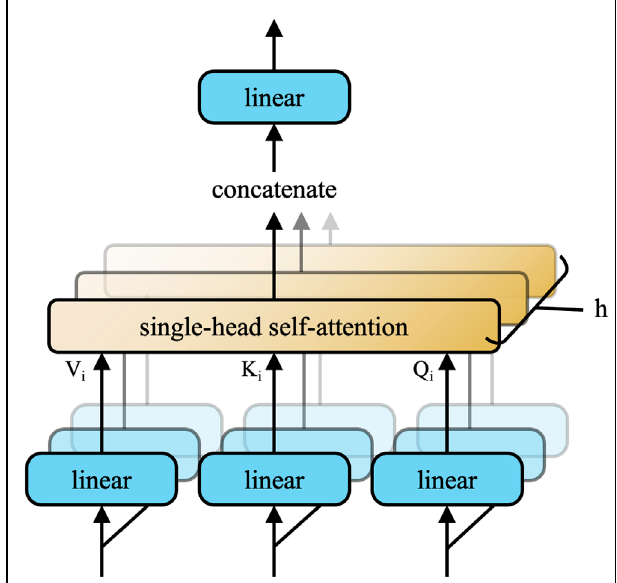
FIGURE 4 | Multi-head attention consists of h single-head attention running in